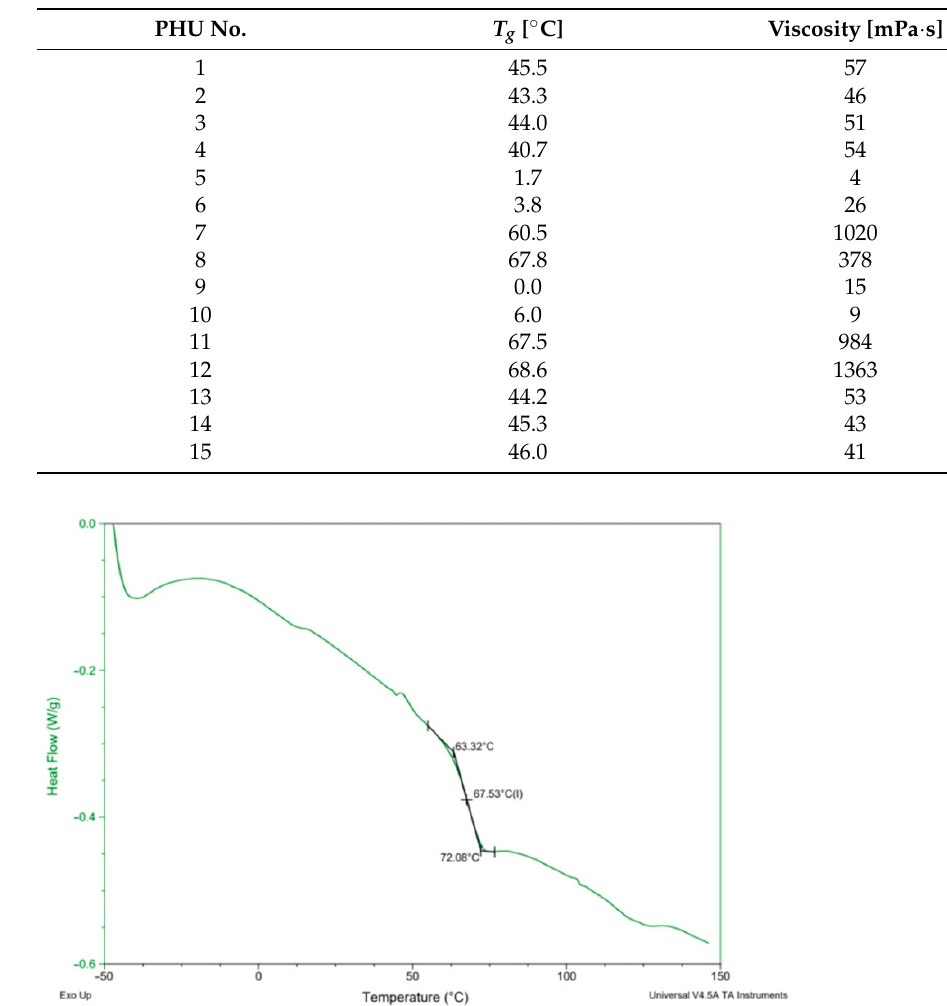
Figure 7. An exemplary DSC curve of PHU run no. 11.